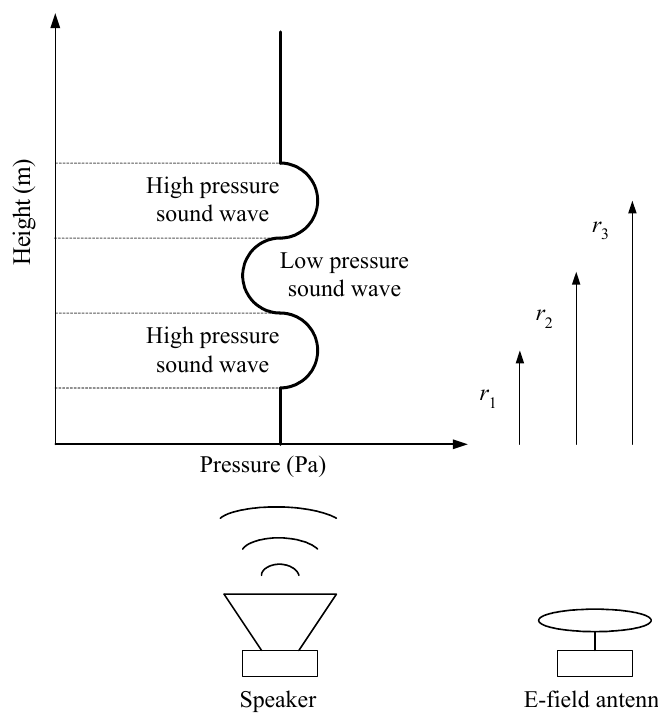
Figure 1 . A schematic illustration of the principle of the developed